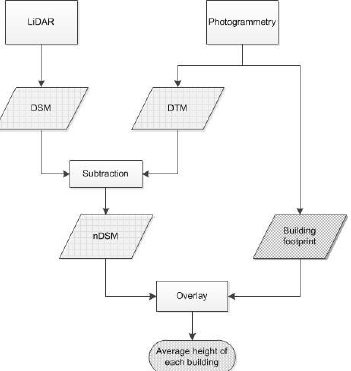
Figure 2. Flowchart with the methodology to extract volume information, at the building